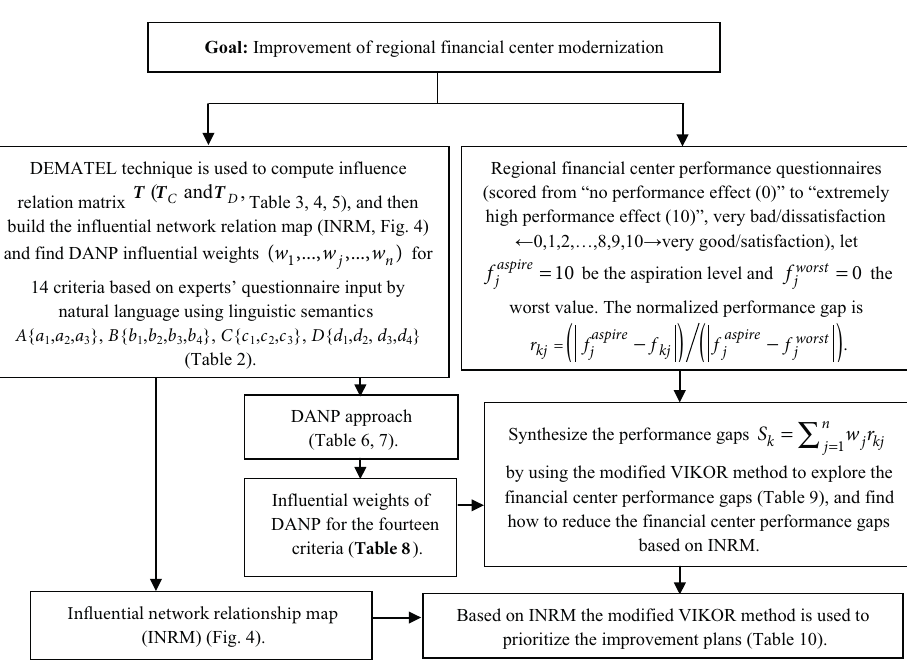
Fig. 2. Diagram of the process for the empirical